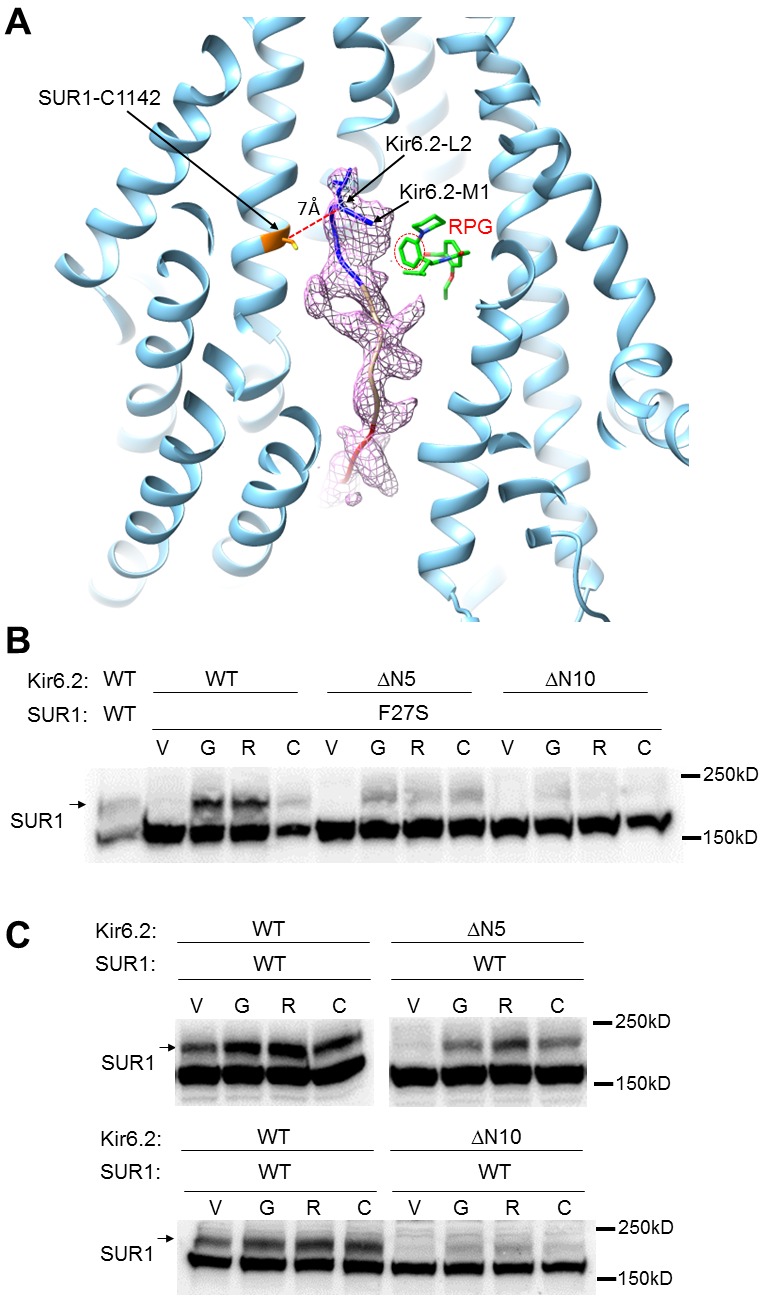
The distal N-terminus of Kir6.2 interacts with SUR1 and is required for channel biogenesis and pharmacochaperone rescue.(A) Kir6.2 N-term cryoEM density (pink mesh) with superposed polyalanine model shown in the RPG (green) bound SUR1 structural model. The piperidino moiety of RPG is highlighted with dotted red line to show its close proximity to the N-terminal methionine of the modeled Kir6.2 N-terminal peptide. The relationship between SUR1 C1142 and Kir6.2 L2 is shown to illustrate their close proximity, with Cα-Cα distance of ~7 Å. The Kir6.2 N-term density map was obtained by removing densities corresponding to modeled SUR1 and RPG from the focus-refined RPG/ATP map using the Color Zone option in Chimera, contoured to 12σ. The polyalanine model of the Kir6.2 N-term corresponding to amino acids 1–5 is shown in blue, 5–10 in tan, and 10–15 in red. (B) Western blot showing that deletion of Kir6.2 amino acids 2–5 (ΔN5) or amino acids 2–10 (ΔN10) attenuated or nearly abolished, respectively, the pharmacochaperoning effect [compared to 0.1% DMSO vehicle control (V)] of GBC (G; 1 µM), RPG (R; 1 µM), and CBZ (C; 10 µM) on the SUR1-F27S mutant. (C) Western blot showing Kir6.2 ΔN5 and ΔN10 also greatly impaired maturation of WT SUR1 (V), and rendered GBC, RPG, and CBZ less and less effective in enhancing WT SUR1 maturation.